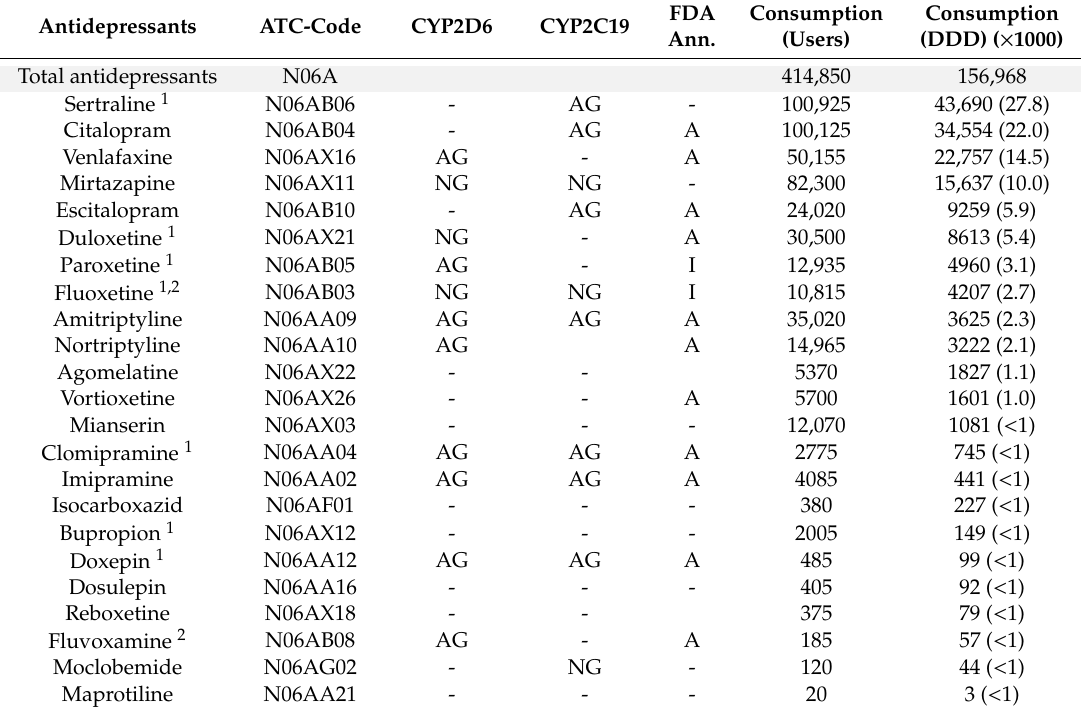
The table is sorted in order of increasing consumption. AG: actionable guideline, N-AG: non-actionable guideline, and -: no guideline. FDA annotation (FDA ann.) related to CYP2D6 and / or CYP2C19. Numbers in brackets are